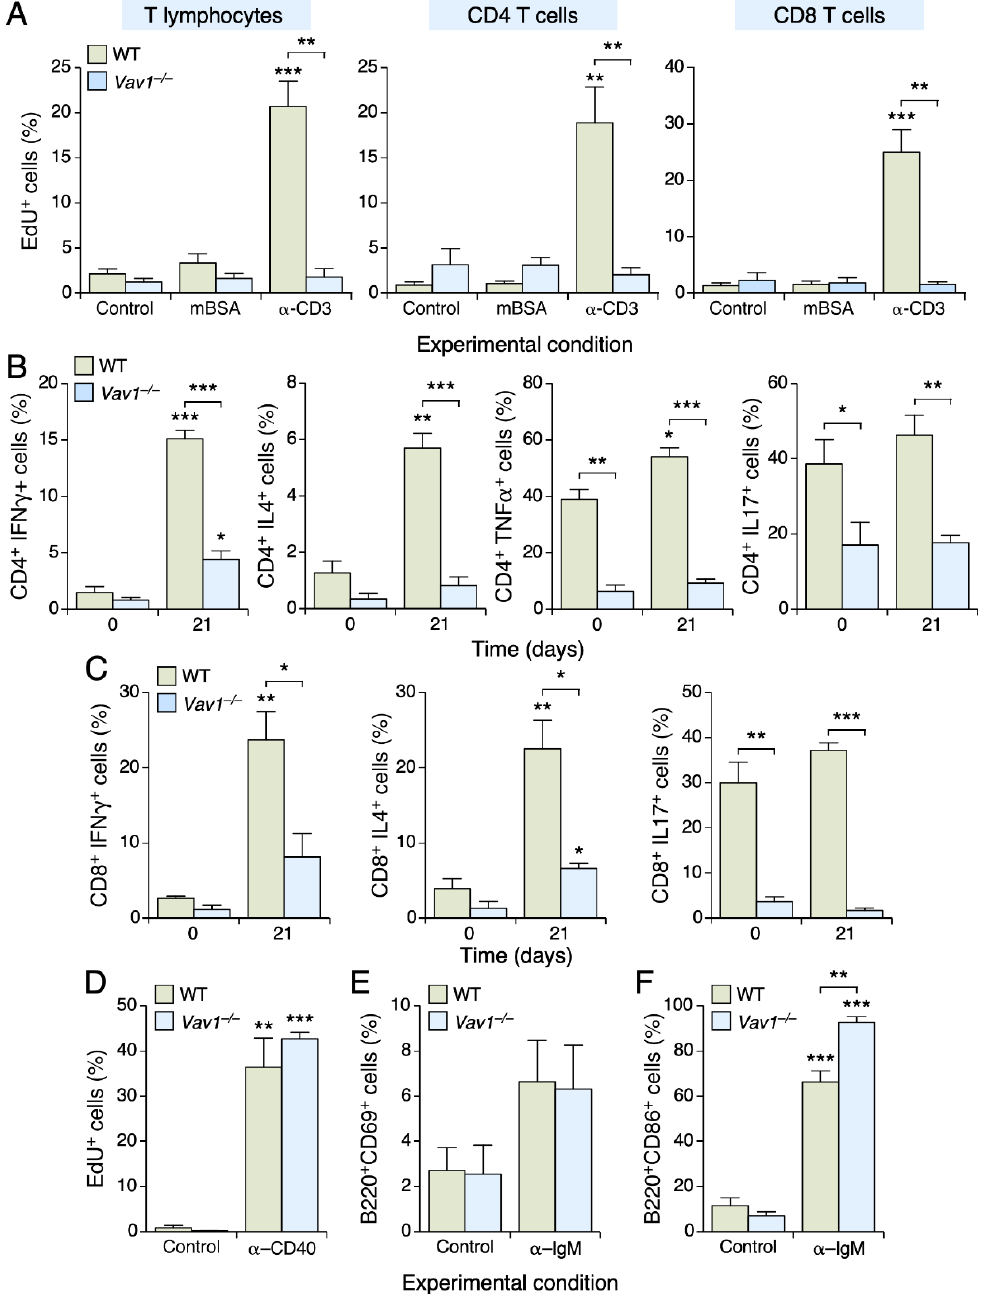
Figure 3. The Vav1 deficiency impairs T cell proliferation and differentiation. ( A ) Percentage of EdU + cells present in the T cell populations (top) from mice of indicated genotypes (inset). The experimental conditions used in each case are indicated at the bottom. ( B ) Percentage of lymph node CD4 + T H1 (IFN γ + and TNF α + ), T H2 (Il4 + ) and T H17 (Il17 + ) cells in mice of the indicated genotypes at the indicated times upon the first intra-dermal immunization with mBSA. Note that cells have been costimulated with antibodies to both CD3 and CD28. ( C ) Percentage of lymph node CD8 + T C1 (IFNγ + ), T C2 (Il4 + ) and T C17 (Il17 + ) generated and stimulated as in B. ( D ) Percentage of EdU + B cells in the indicated experimental animals and conditions. ( E , F ) Percentage of B220 + B lymphocytes expressing the activation markers CD69 ( E ) and CD86 ( F ) obtained from animals of the indicated genotypes. The experimental conditions used are indicated at the bottom. Data shown in panel A to F represent the mean ± SEM. *, p ≤ 0.05; **, p ≤ 0.01; ***, p ≤ 0.001. Values are given relative to the values obtained in each genotype control ( A , D , F ), in CD3- ( A ) or IgM-stimulated ( D – F ) WT cells, in the experimental time point 0 of animals belonging to the same genotype ( B , C ) or in the appropriate time point using WT cells ( B , C ). n = 3 independent experiments in each case.